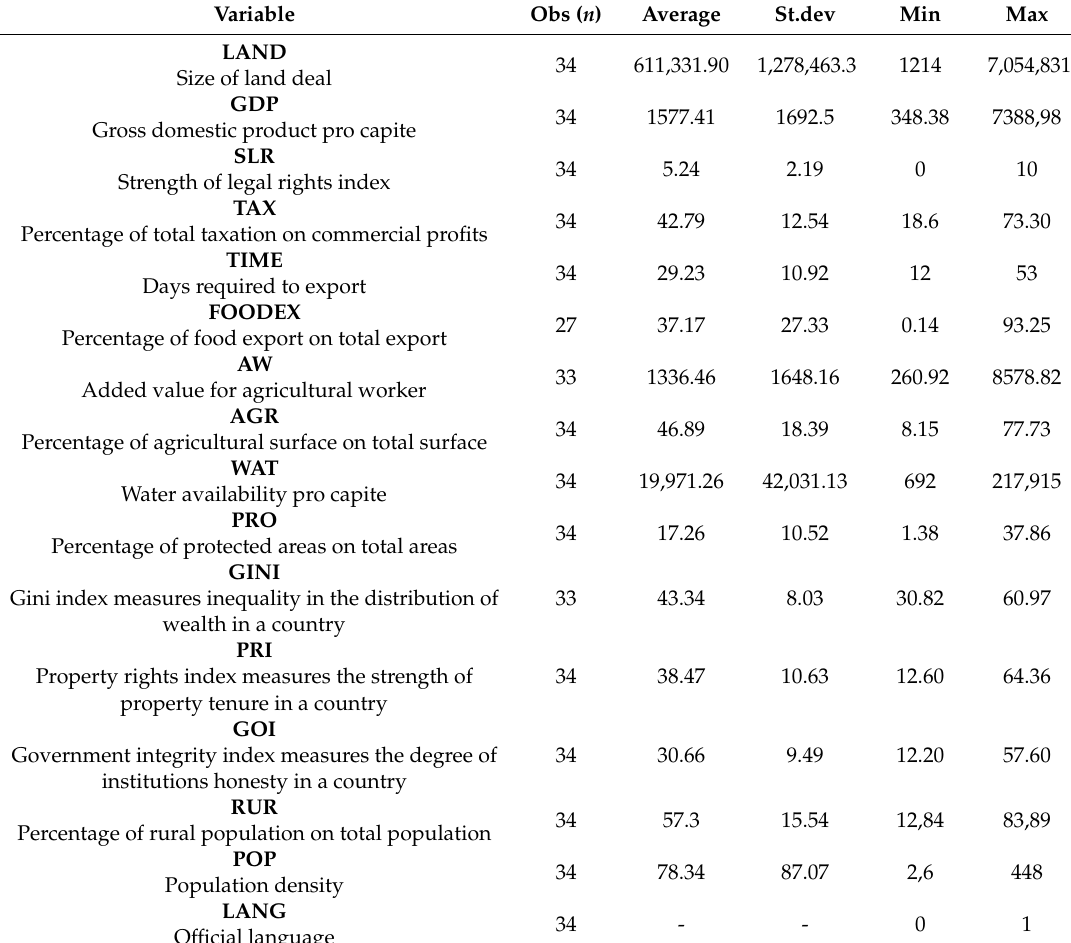
Table 3. Descriptive statistics of the variables.